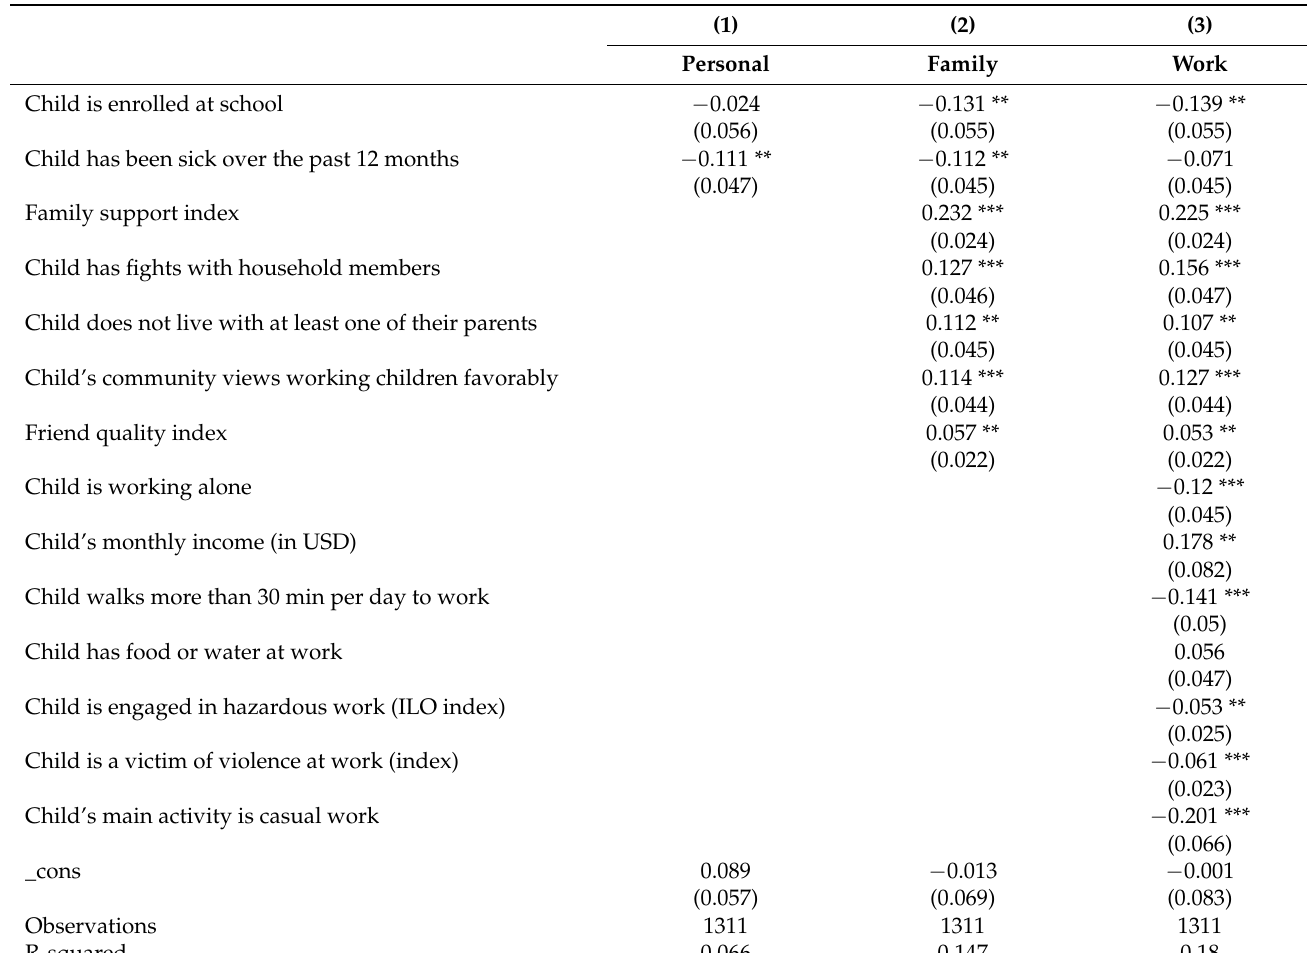
Table A5. Linear regressions for self-agency